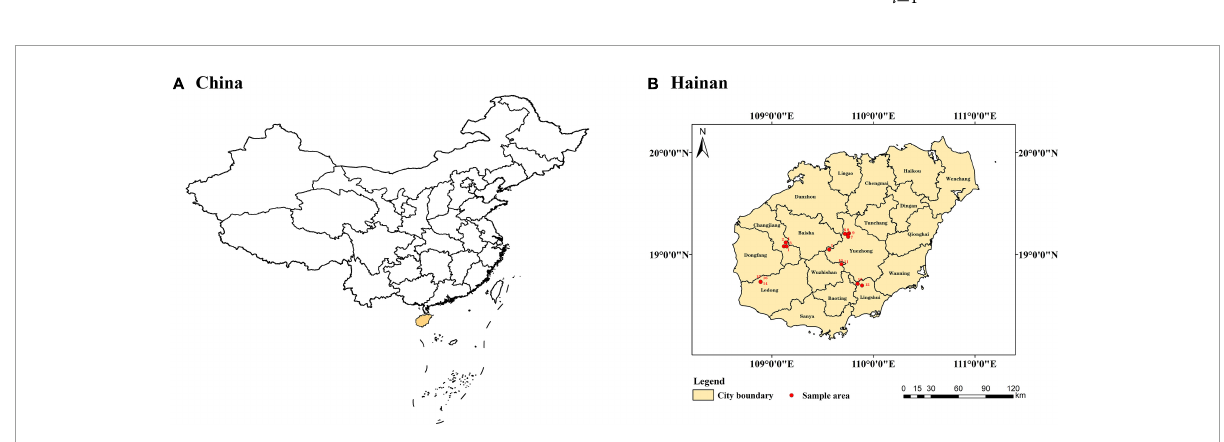
FIGURE1 (A) Hainan Island is located in the yellow region of China. (B) Basic status of Hopea hainanensis populations in Hainan Island,